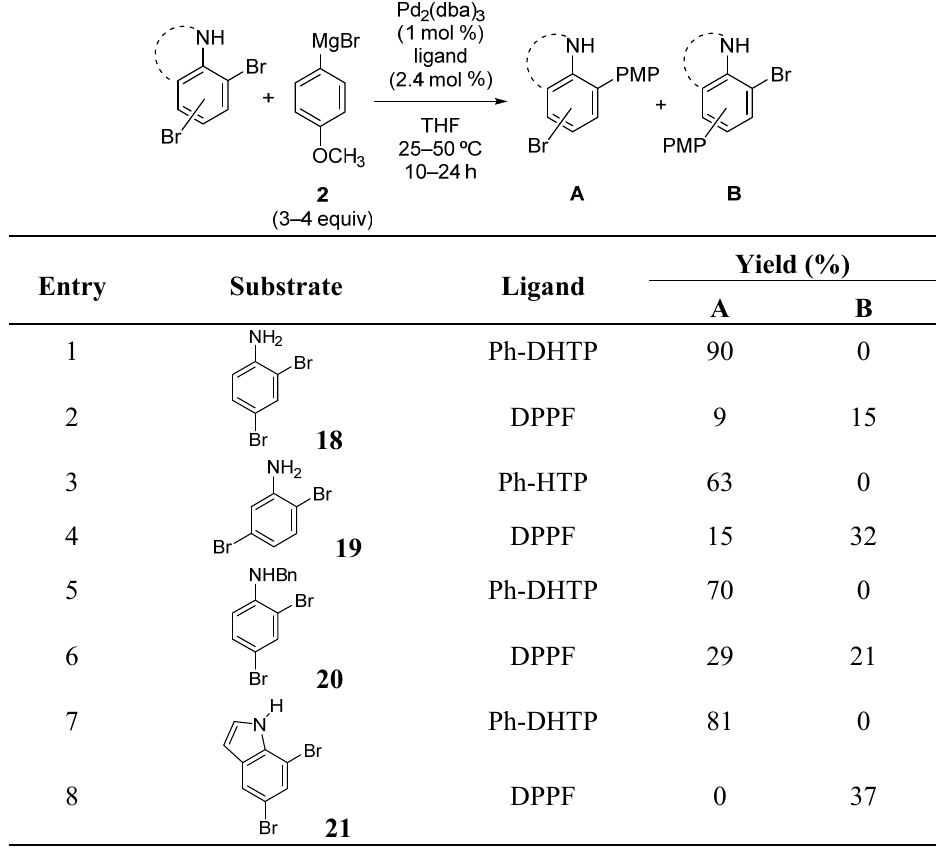
Table 1. Site-selective cross-coupling of dibromoaniline derivatives and